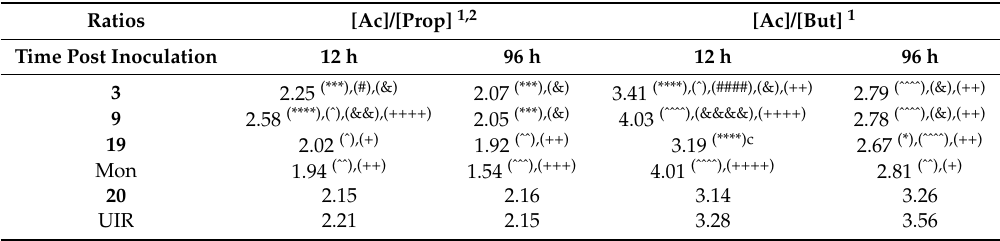
Table 1. Effect of the different compounds on the rumen SCFA concentration